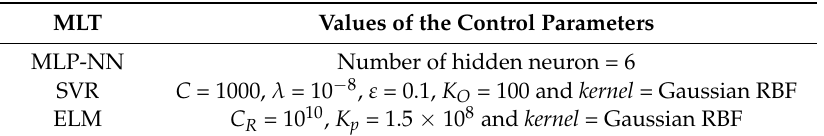
Table 3. Randomly selected machine learning tools (MLT) control